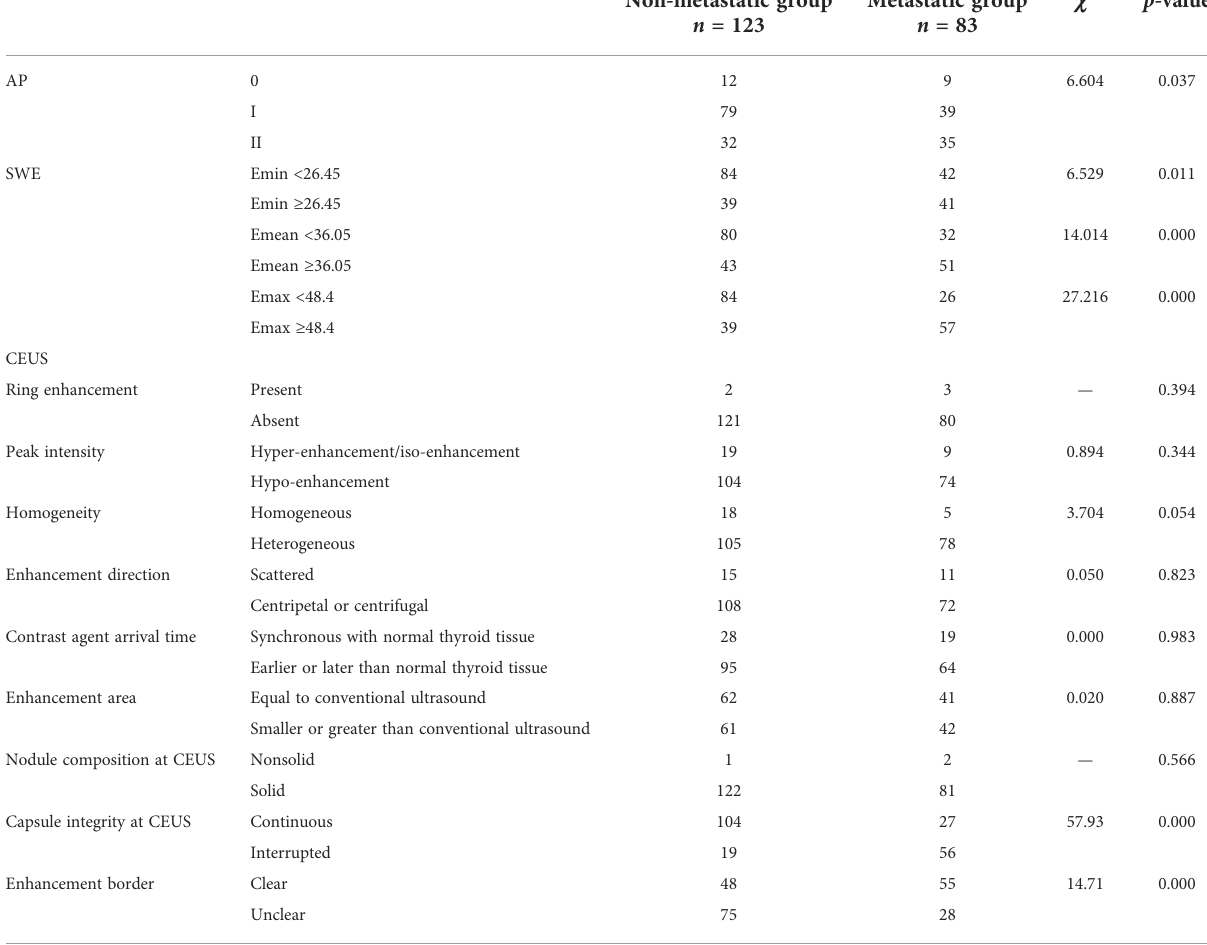
TABLE 2 AP, SWE, and CEUS features between the non-metastasis and metastasis group.